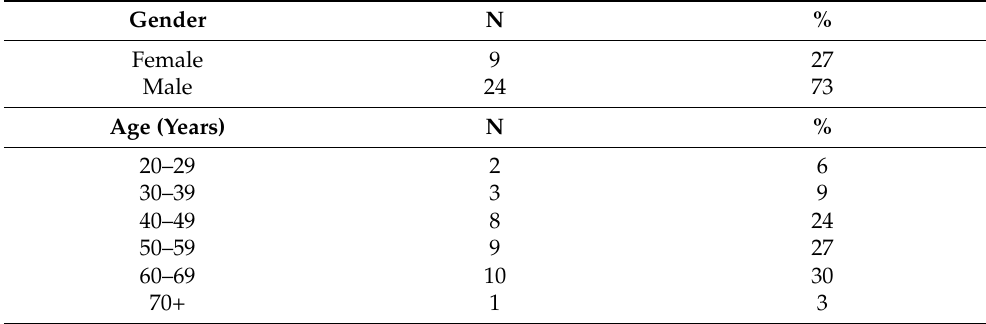
Table 1. Characteristics of